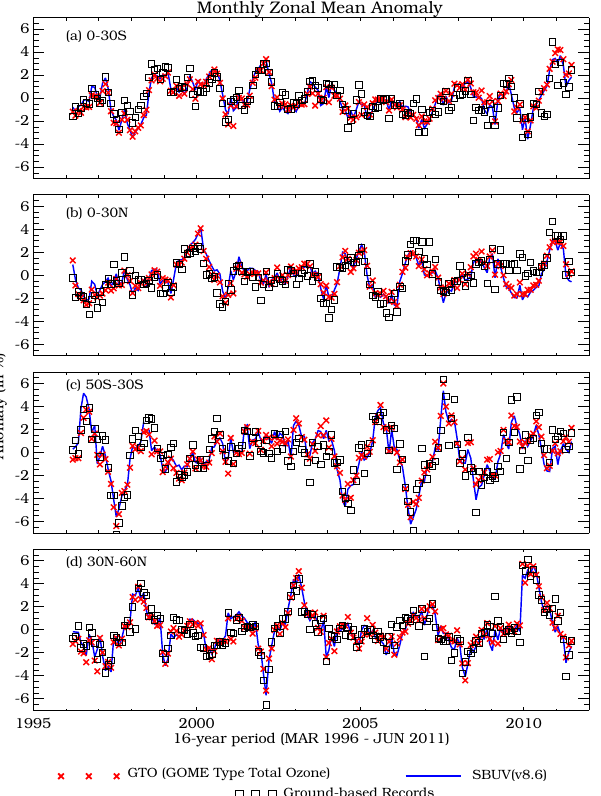
Figure 8. Differences in monthly mean zonal mean